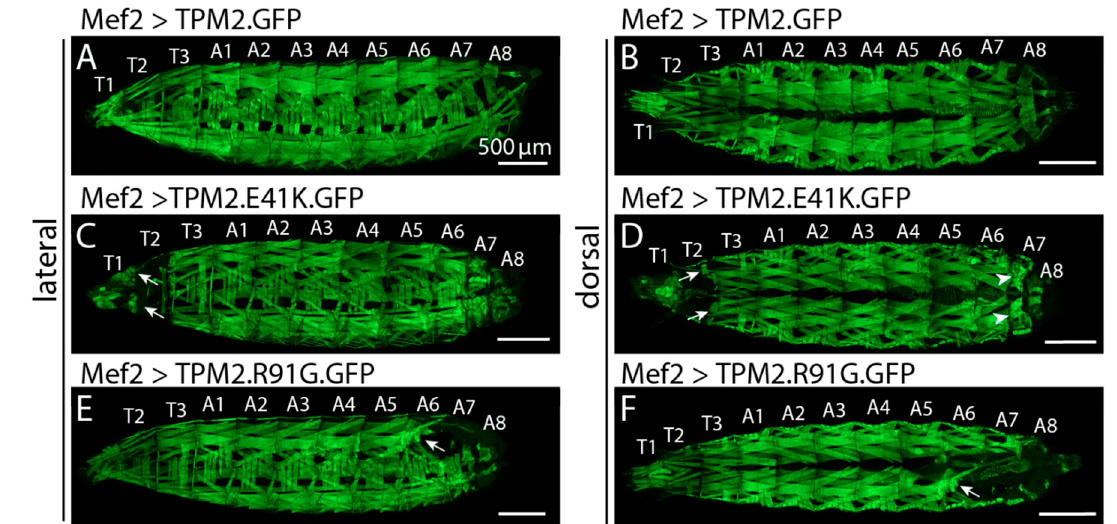
Figure 2. DA associated TPM2 variants cause muscle phenotypes in Drosophila . Confocal micrographs of live L3 larva that express GFP-tagged TPM2 variants in skeletal muscles (body wall muscles). Mef2.Gal4 was used to activate UAS.TPM2 transgenes. Lateral and dorsal views are shown for each genotype. ( A , B ) Larva that express TPM2.GFP showed normal muscle histology. Larva that expresses TPM2.E41K.GFP ( C , D ) or TPM2.R91G.GFP ( E , F ). GFP have rounded myofibers that appear to result from internal tears (arrows; note affected muscles remain associated with tendons at segment boundaries) and shortened segments that could be due to hypercontractile muscles (arrowheads). Thoracic segments (T1–T3) and abdominal segments (A1–A8) are labeled. Scale bars, 500 mM. Previously unpublished data.